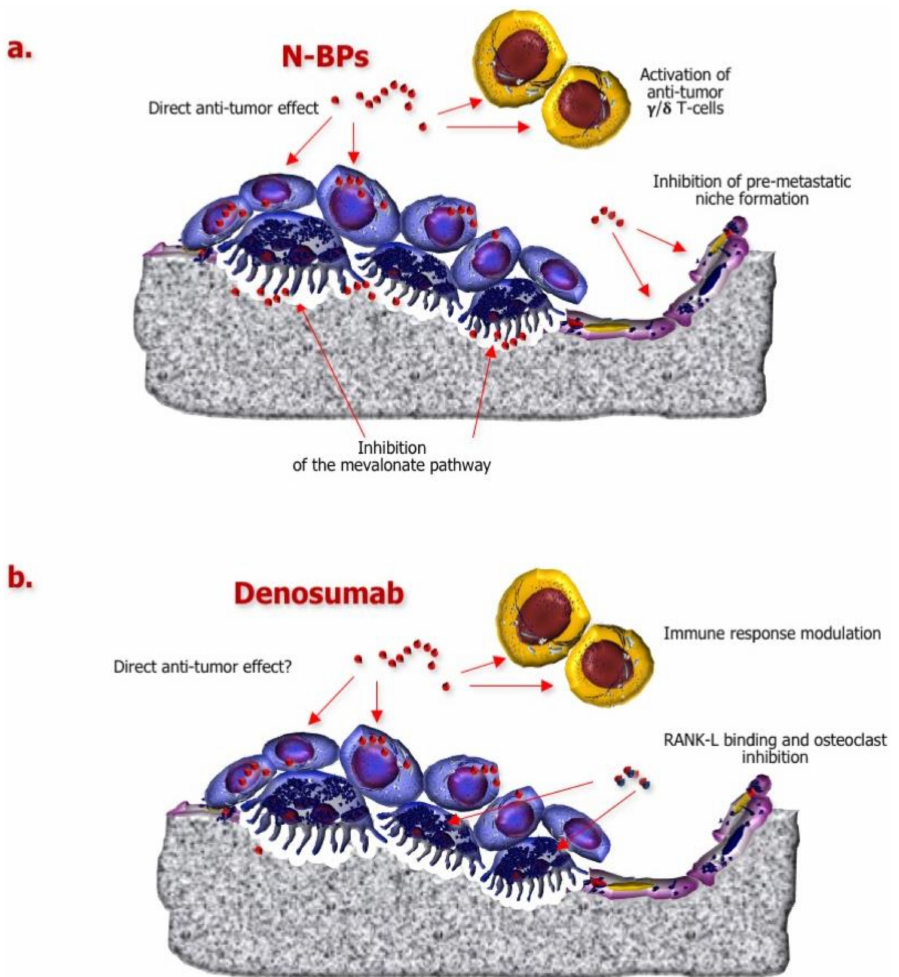
Figure 3. Pleiotropic e ff ects of approved bone-targeting agents (BTAs). ( a ) Nitrogen-containing bisphosphonates (N-BPs) inhibit a key enzyme of the mevalonate pathway, namely the farnesyl pyrophosphate synthase, which is critical for osteoclast activity and survival. These BTAs also interfere with the formation of premetastatic niches by targeting osteoblasts and endothelial cells, as well as by inhibiting angiogenesis. Direct activities against BC cells, such as apoptosis induction and invasiveness inhibition, have been also described, along with γδ T-cell activation against tumor cells. ( b ) Denosumab is a fully human anti-RANK-L antibody that neutralizes the interaction of this cytokine with its receptor, RANK, expressed by osteoclasts. Thus, osteoclasts are suppressed in their maturation and activity. However, putative direct inhibitory e ff ects of denosumab on BC carcinogenesis have been also described, together with the capability to improve the anticancer